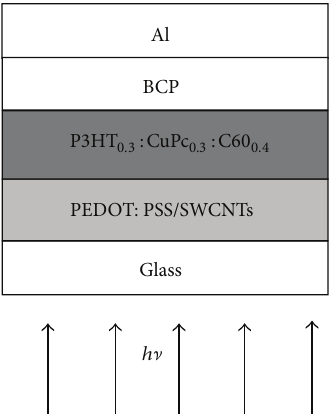
Figure 1: Structure of ITO/PEDOT:PSS/C60:CuPc:P3HT/BCP/Al solar cell.